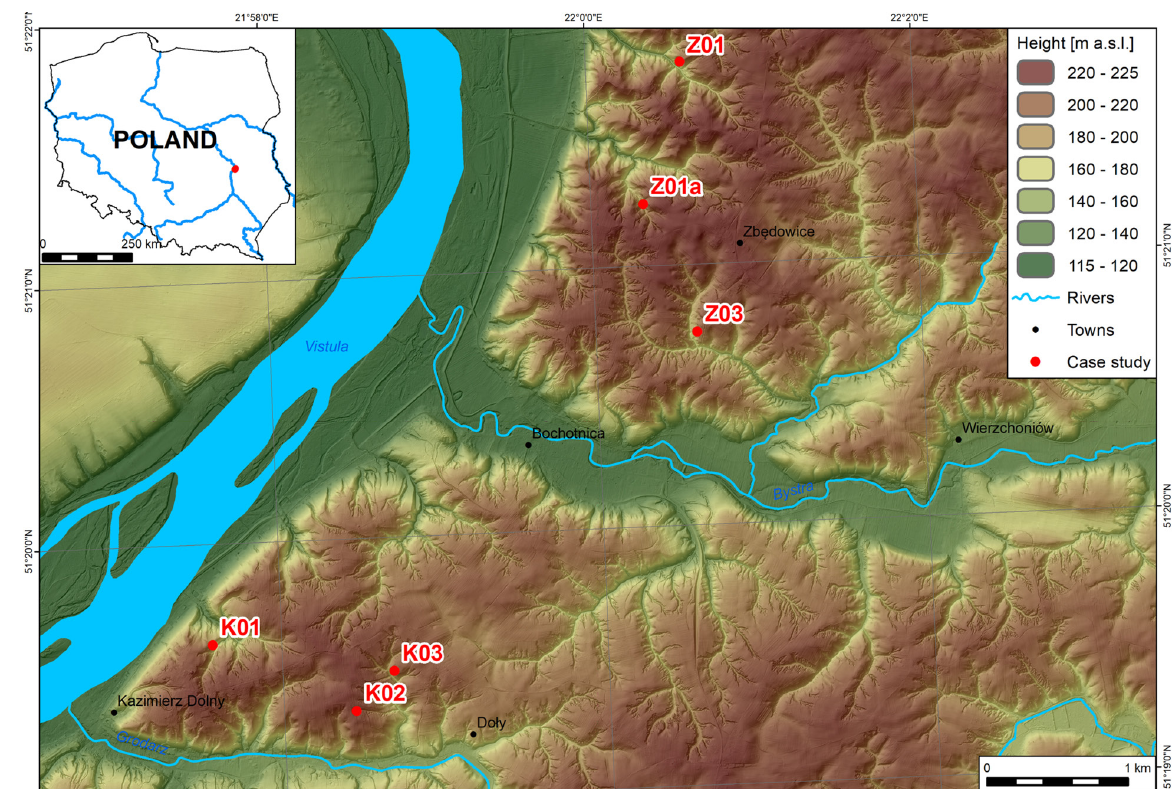
Fig. 1. Location of research sites shown against a LiDAR elevation-based shaded relief map of the western part of the Nałęczów